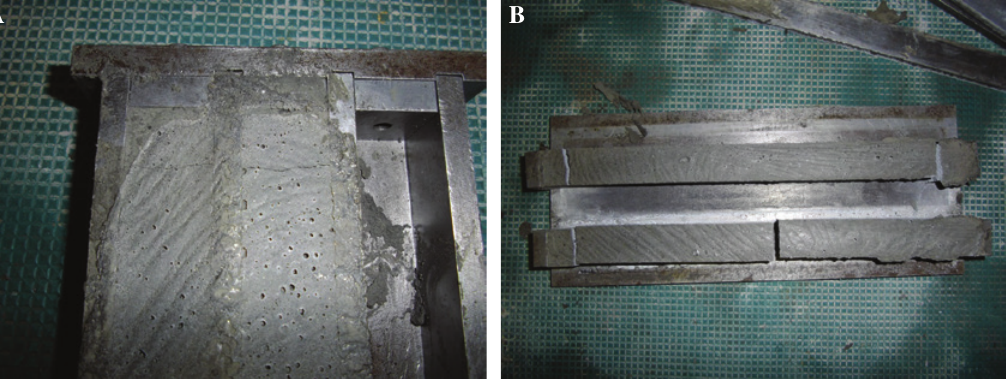
Figure 7: (A) Crack of AAFA mortars with alkaline solution to binder ratio of 0.65 cured at the temperature of 30 ° C for 24 h. (B) Crack of AAFA mortars with alkaline solution to binder ratio of 0.65 cured at the temperature of 65 ° C for 12 h.